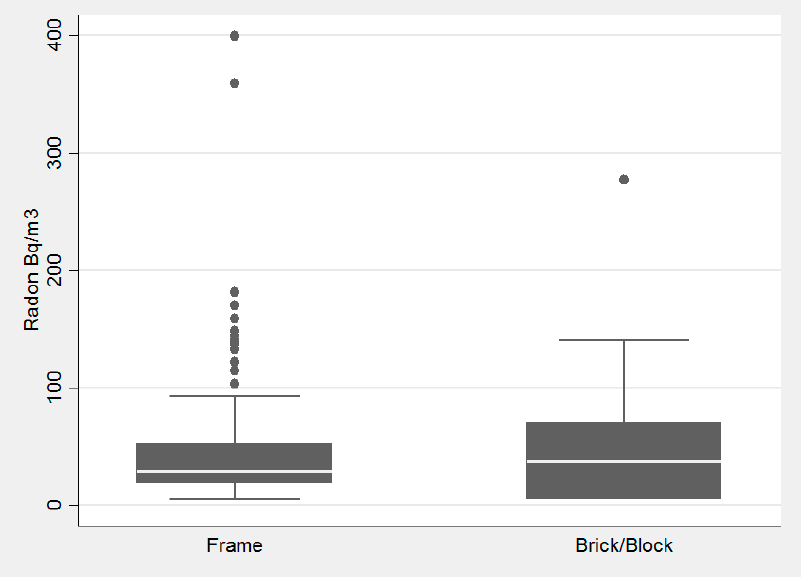
Figure 4. Association with building type and radon concentration in the pilot study of homes tested in DeKalb County in 2015.